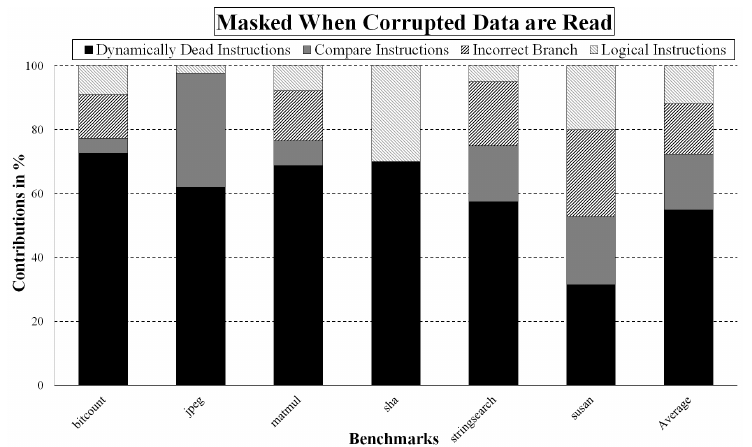
Figure 9. Software-level masking effects for each benchmark when corrupted data is read by commit- ted instructions.